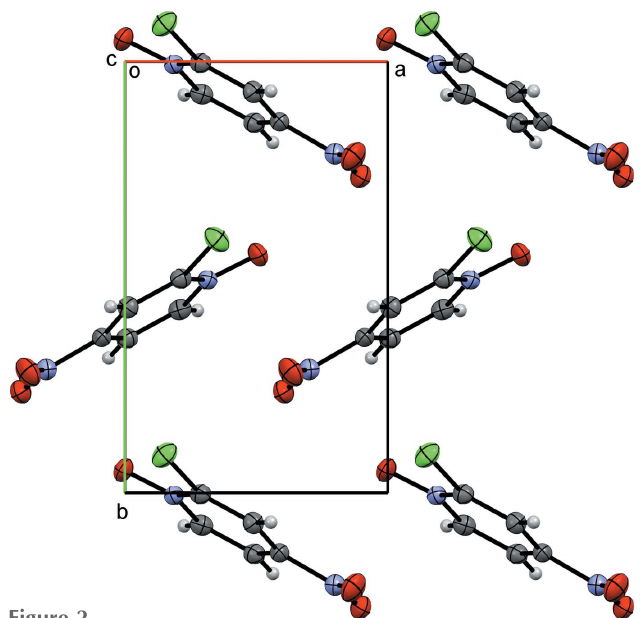
Figure 2 Molecular packing diagram of title compound viewed along the c